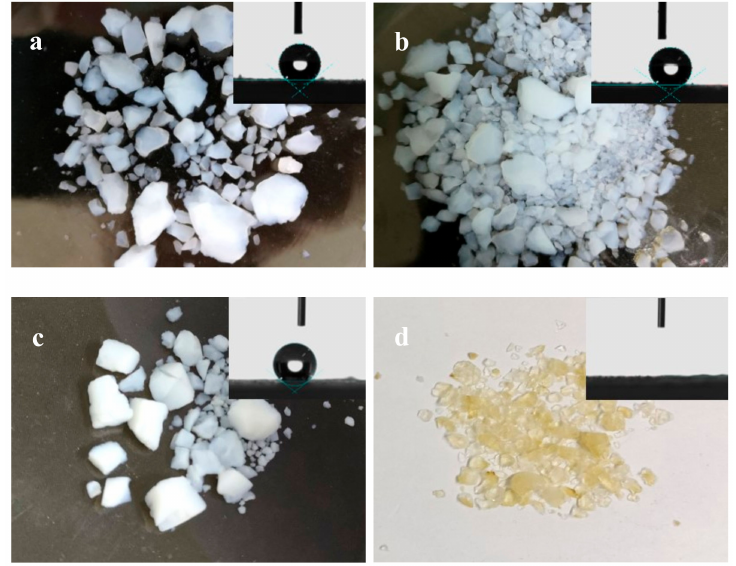
Figure 5. The digital photos and the shapes of water droplets on the surface of the samples (insets).